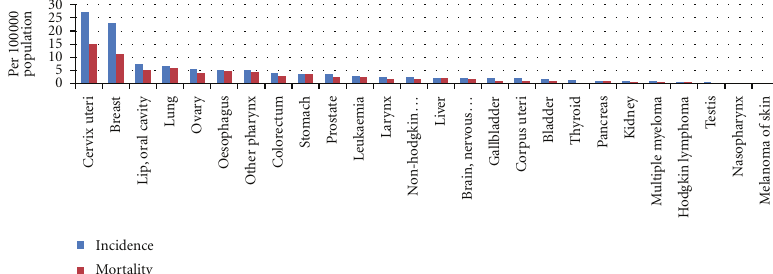
Figure 5: Incidence and mortality rates (age standardised) by cancer type in India—(sexes combined) data extracted from Globocan, 2008 data.